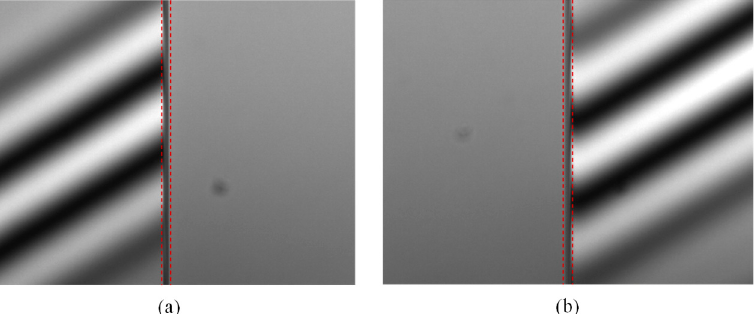
Figure 13. White-light interferograms generated on 7.347 μ m step height: ( a ) upper surface, and ( b ) lower surface.